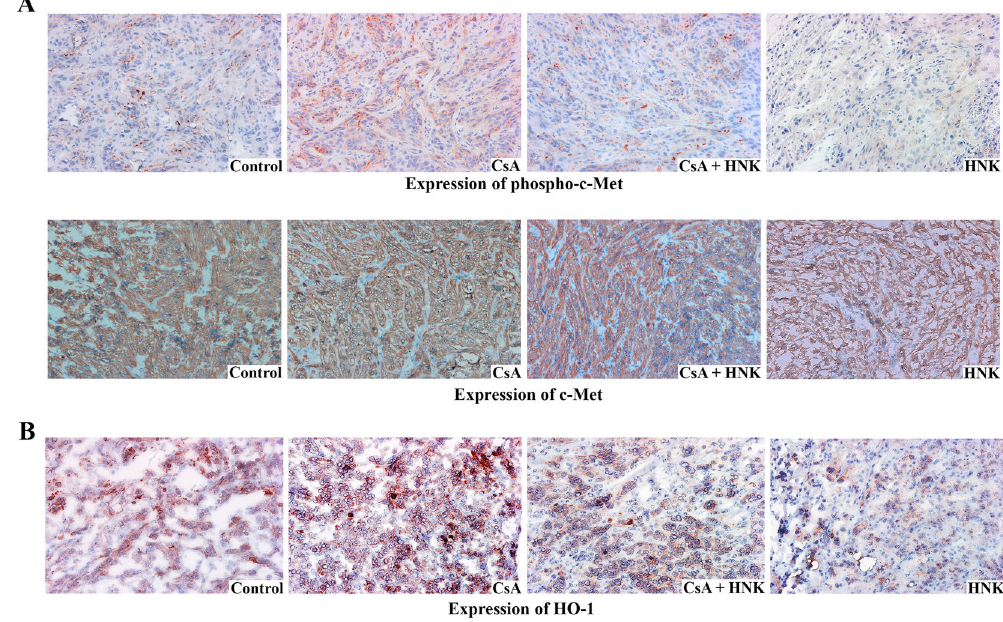
Figure 6. HNK treatment down-regulates CNI-induced c-Met phosphorylation and HO-1 over-expression in renal tumors. IHC stains showing the expression of phospho-c-Met ( A , top panel ) and c-Met ( A , bottom panel ) and HO-1 ( B ) in harvested tumor tissues (as described in Fig. 5). Representative photomicrographs (magnification x400) of three different tumor tissues from each group are